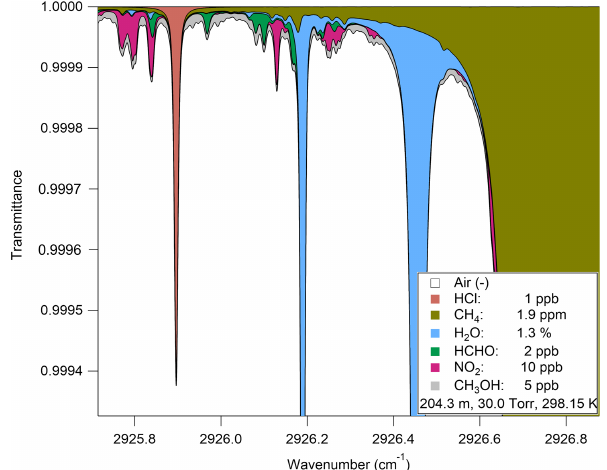
Figure A1. HITRAN transmittance spectrum simulation demon- strating the separation of absorption peaks over the observed spec- tral window (2925.80 to 2926.75cm − 1 )